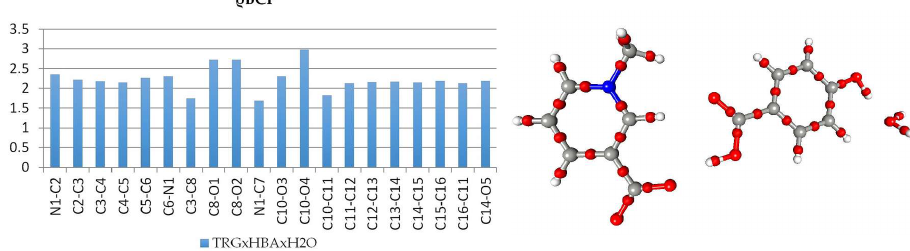
Figure 2. Electron density values [ ρ bcp (e · Å − 3 )] at the covalent bond critical points in 1 ( left ) and graphical representation of bond critical points in molecule 2 ( right ).